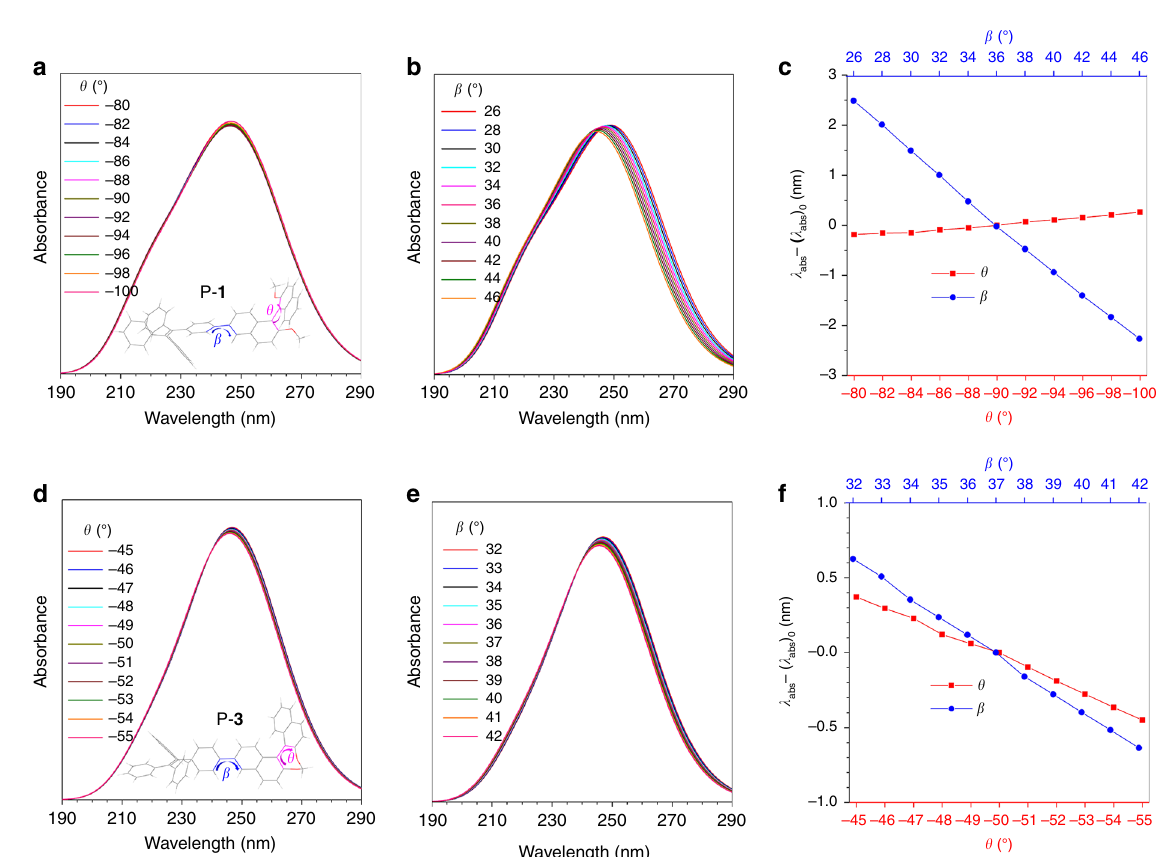
Fig. 8 Simulated photophysical properties of different conformations. a , b , d , e Simulated absorption spectra of a , b P- 1 and d , e P- 3 with θ varying from a − 80° to − 100° and constant β (36°) and d from − 45° to − 55° and constant β (37°), and β varying from b 26° to 46° and constant θ ( − 90°) and e from 32° to 42° and constant θ ( − 50°). c , f Plots of λ abs – ( λ abs ) 0 versus θ and β . λ abs : simulated absorption maximum, ( λ abs ) 0 : simulated absorption maximum wavelength of P- 1 at θ = − 90° and β = 36°; and P- 3 at θ = − 50° and β = 37°. θ = torsion angle between two naphthalene rings, β = torsion angle between the naphthalene and phenyl ring of the TPE moiety. A semi empirical CIS/ZINDO method was applied with NStates = 10 and all calculations were performed using Gaussian 09. For the purposes of a clear demonstration and simpli fi ed calculation, the hexyl groups are replaced with methyl groups in P- 1